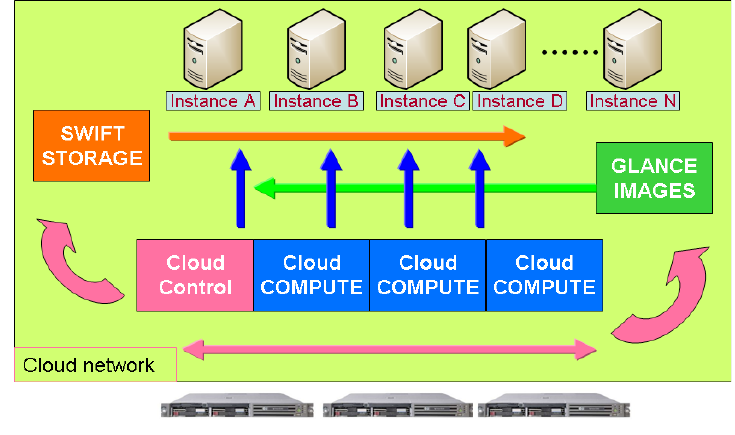
Figure 10. Cloud Control and Cloud Compute